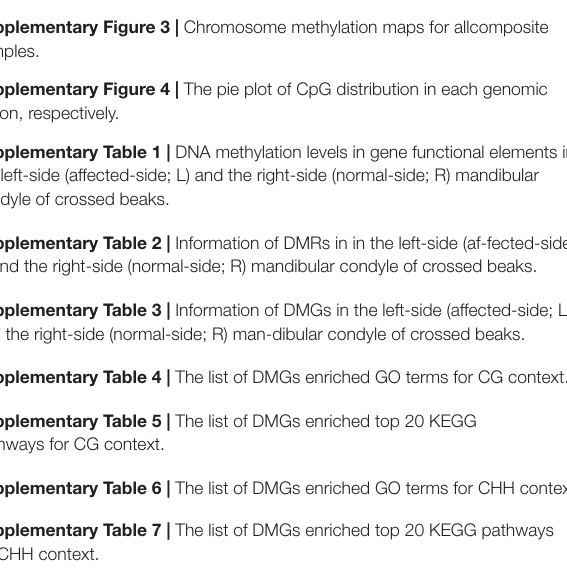
density of the point at that methylation level, while the boxplot shows the methylation levels in each violin. Supplementary Figure 3 | Chromosome methylation maps for allcomposite samples. Supplementary Figure 4 | The pie plot of CpG distribution in each genomic region, respectively. Supplementary Table 1 | DNA methylation levels in gene functional elements in the left-side (affected-side; L) and the right-side (normal-side; R) mandibular condyle of crossed beaks.